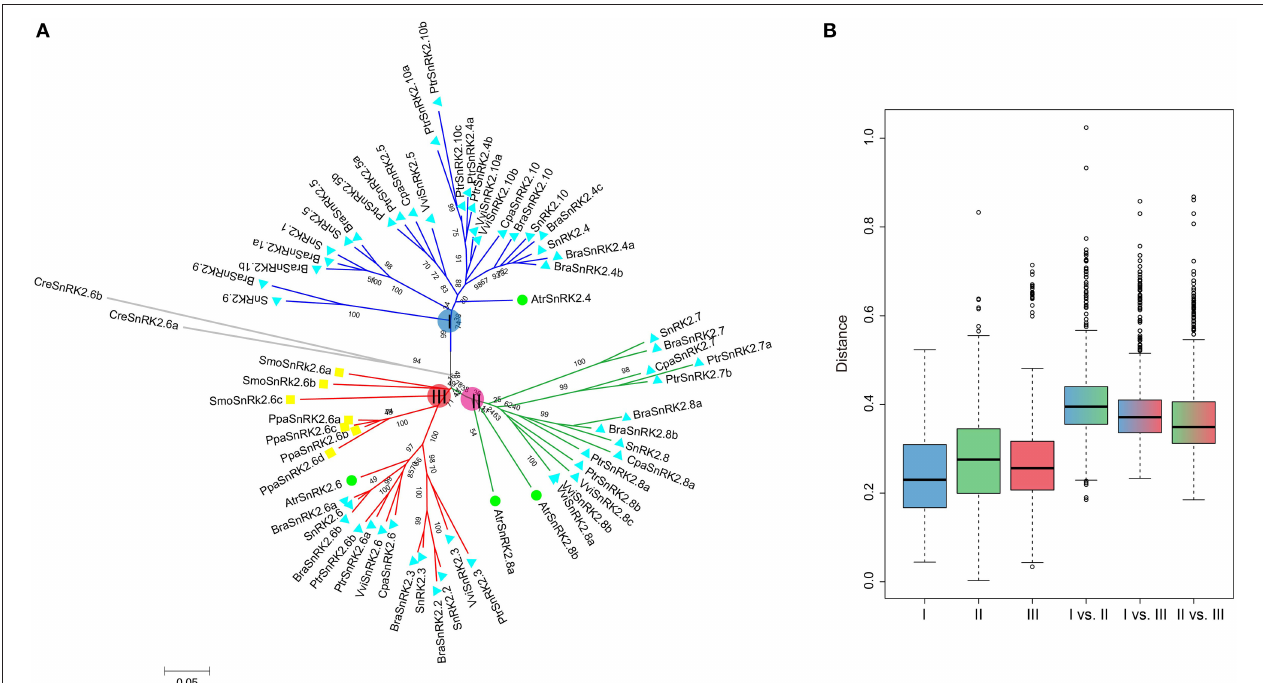
FIGURE 1 | Phylogenetic relationships among SnRK2 genes in nine plant species (A) and the genetic distance among different groups of SnRK2 genes (B). Group I, II, and III are shaded blue, green, and red, respectively. In (A) , the short species names are C. reinhardtii (Cre), P. patens (Ppa), S. moellendorffii (Smo), A. trichopoda (Atr), V. vinifera (Vvi), P. trichocarpa (Ptr), C. papaya (Cpa), B. rapa (Bra), and A. thaliana (Ath).The phylogenetic tree was constructed using maximum likelihood (ML) and bootstrap values calculated with 1000 replications using MEGA5 (Tamura et al., 2011). The SnRK2s of A. trichopoda were indicated by green balls, S. moellendorffii and P. patens were indicated by yellow squares, others were indicated by blue triangles.